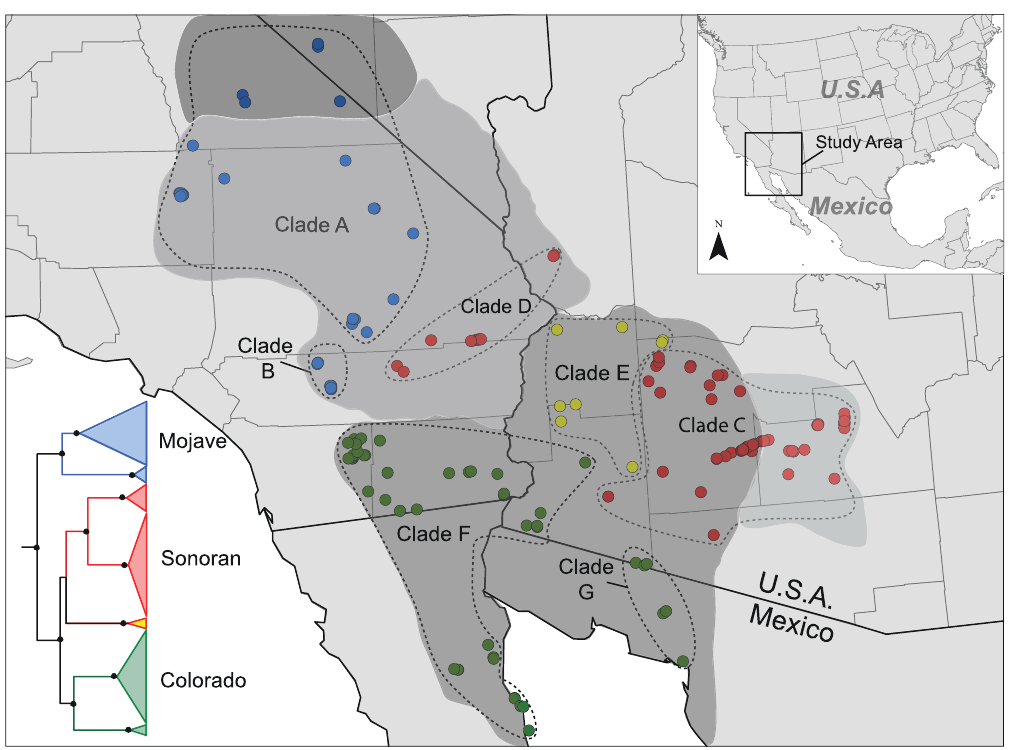
Figure 2. Phylogeny for the western shovel-nosed snake ( Chionactis occipitalis ) based on partitioned Bayesian analysis of mitochondrial DNA sequence data (16S rRNA and ND1 genes) and the geographic distribution of the major lineages (Mojave lineage in blue, Sonoran lineage in red, and Colorado lineage in green). The geographic distribution of clades within each lineage are outlined with a dashed line, clade E (yellow clade and dots) was routinely placed as sister to the Sonoran lineage, but posterior probabilities supporting this relationship were weak ( Pp , 0.50). Black circles at nodes represent Bayesian posterior probabilities of $ 0.95. See Figures S1-3 for more detail within each mtDNA